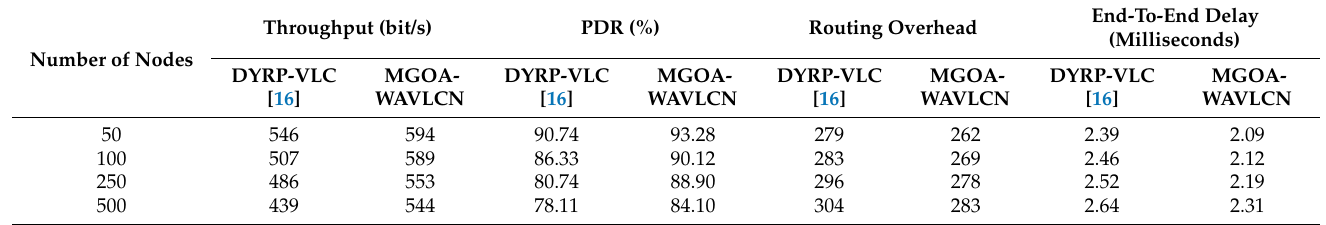
Table 7. Comparison of the MGOA-WAVLCN and